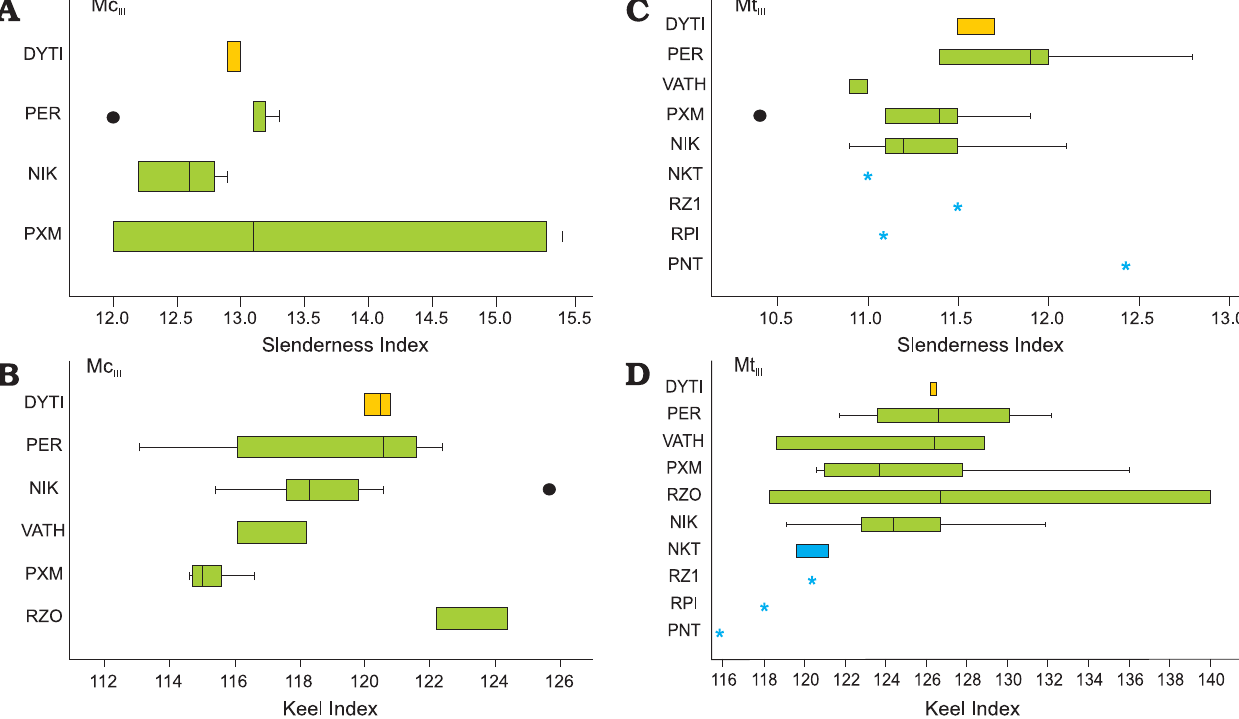
Fig. 13. Slenderness and Keel indexes for the third metacarpal ( A , B ) and metatarsal ( C , D ) of Hipparion macedonicum from the various Greek localities. Dots indicate